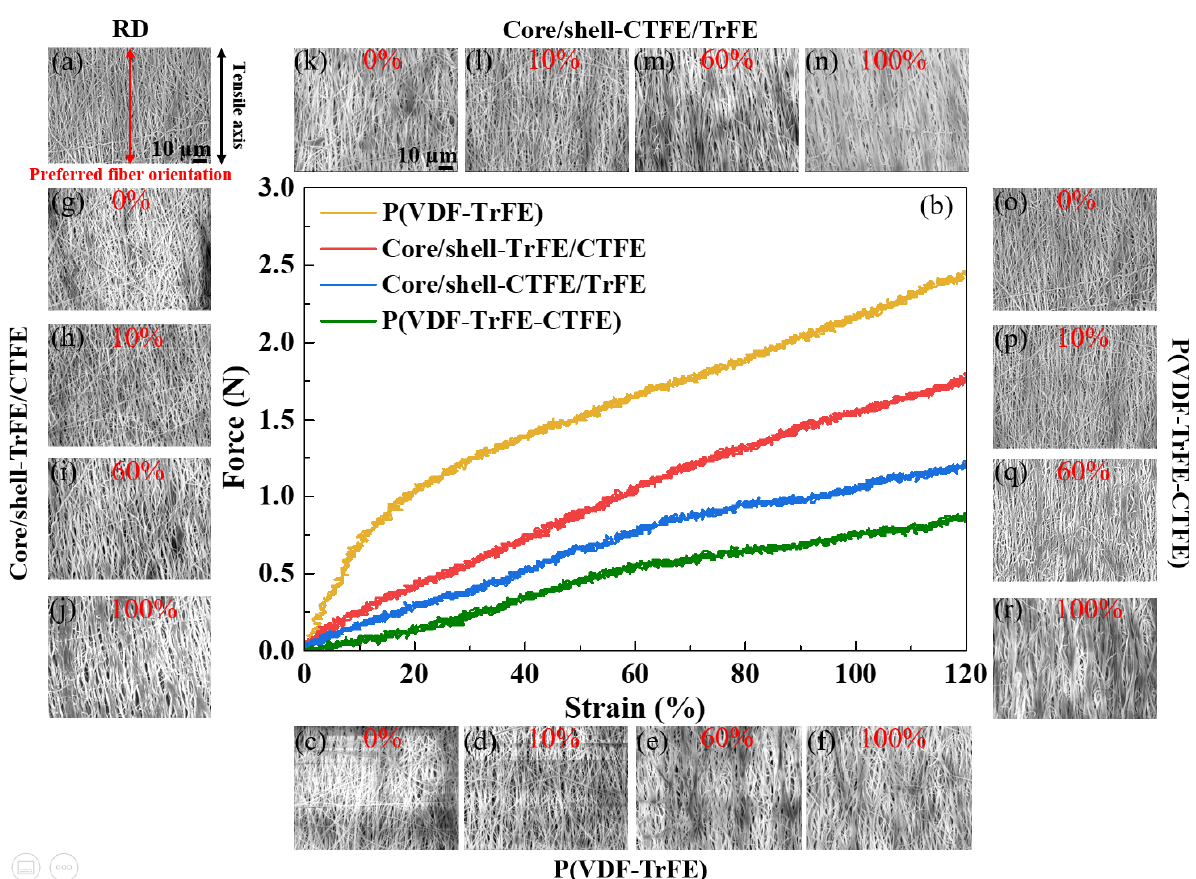
Figure 1. ( a ) Schematic illustration of the tensile test in the RD. The black arrow represents the tensile direction. ( b ) Force-strain curves of the four types of electrospun membranes in the RD. ( c – f ) are SEM images of single P(VDF-TrFE) at the designated strains of 0%, 10%, 60%, and 100%, respectively. ( g – j ) are SEM images of core/shell-TrFE/CTFE at the same designated strains, respectively. ( k – n ) are SEM images of core/shell-CTFE/TrFE at the same designated strains,